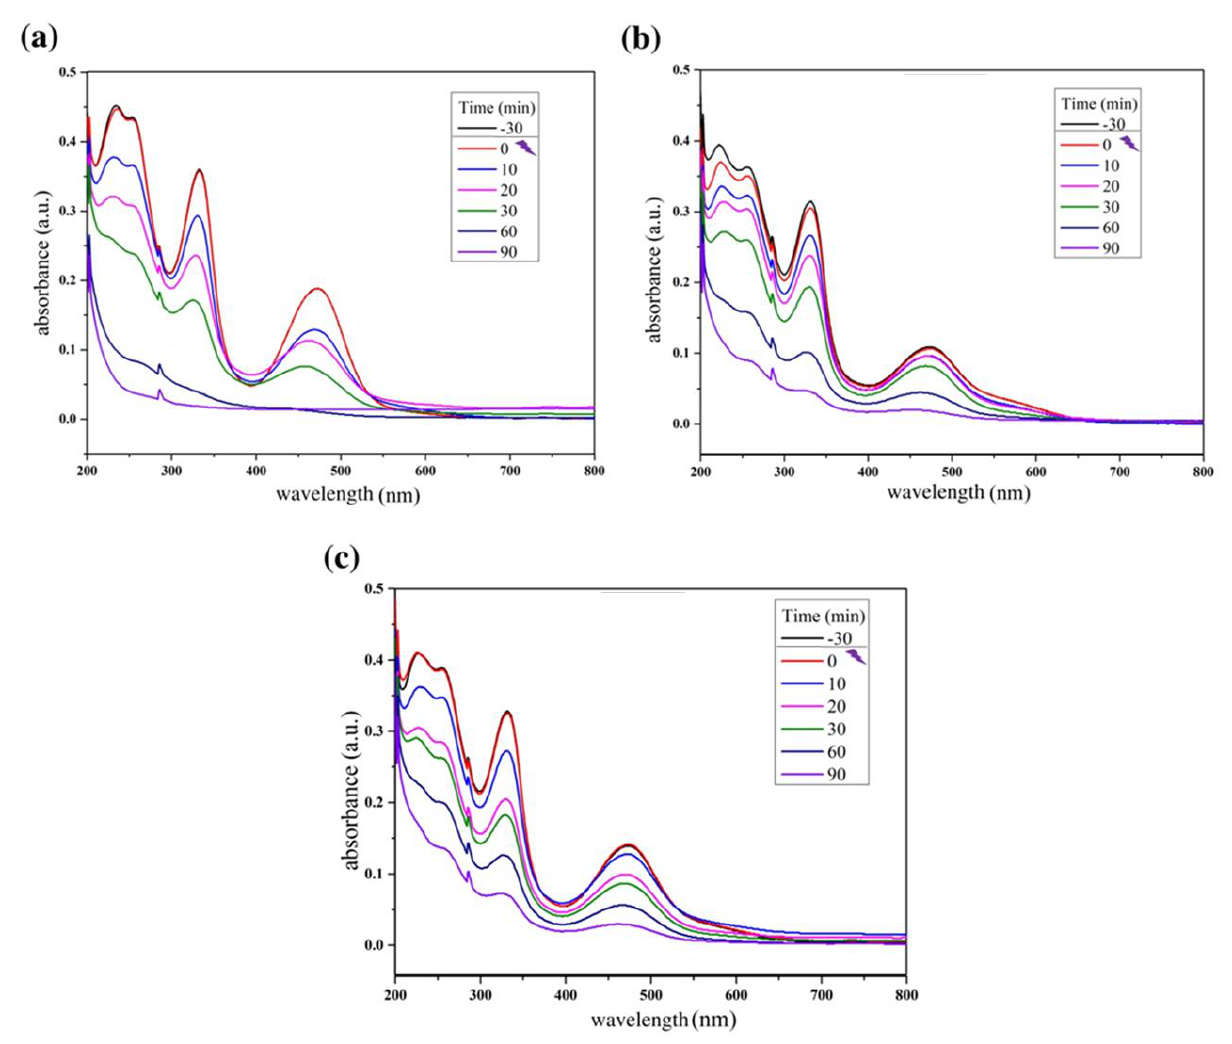
Figure 4. Reaction absorbance spectra of rifampicin solution during the photocatalytic tests using